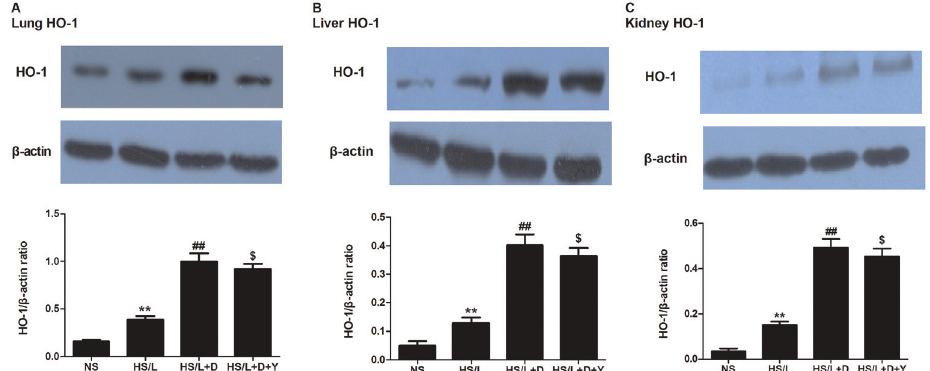
Figure 6. Heme oxygenase-1 (HO-1) protein expression in the lung ( A ), liver ( B ), and kidney ( C ) of the NS control (normal saline), hemorrhage/resuscitation plus lipopolysaccharide (HS/L), HS/L plus dexmedetomidine (HS/L + D), and HS/L + D plus yohimbine (HS/ L + D + Y) groups. Data are reported as means ± SD. **P o 0.01 vs the NS group; ## P o 0.01 vs the HS/L group; $ P o 0.05 vs the HS/L + D group (ANOVA). n=10/group.